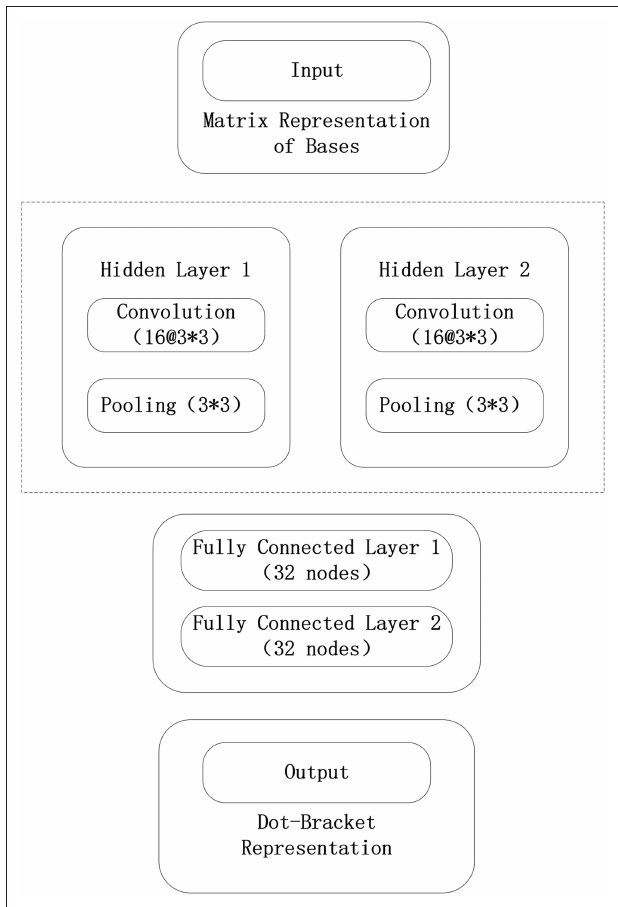
FIGURE 11 | Convolutional neural network model in general model.